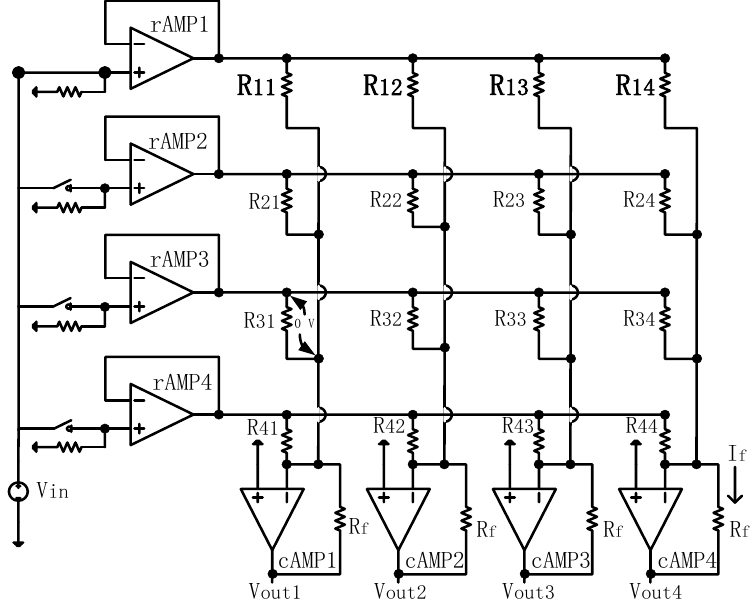
Figure A1. Circuit based on the